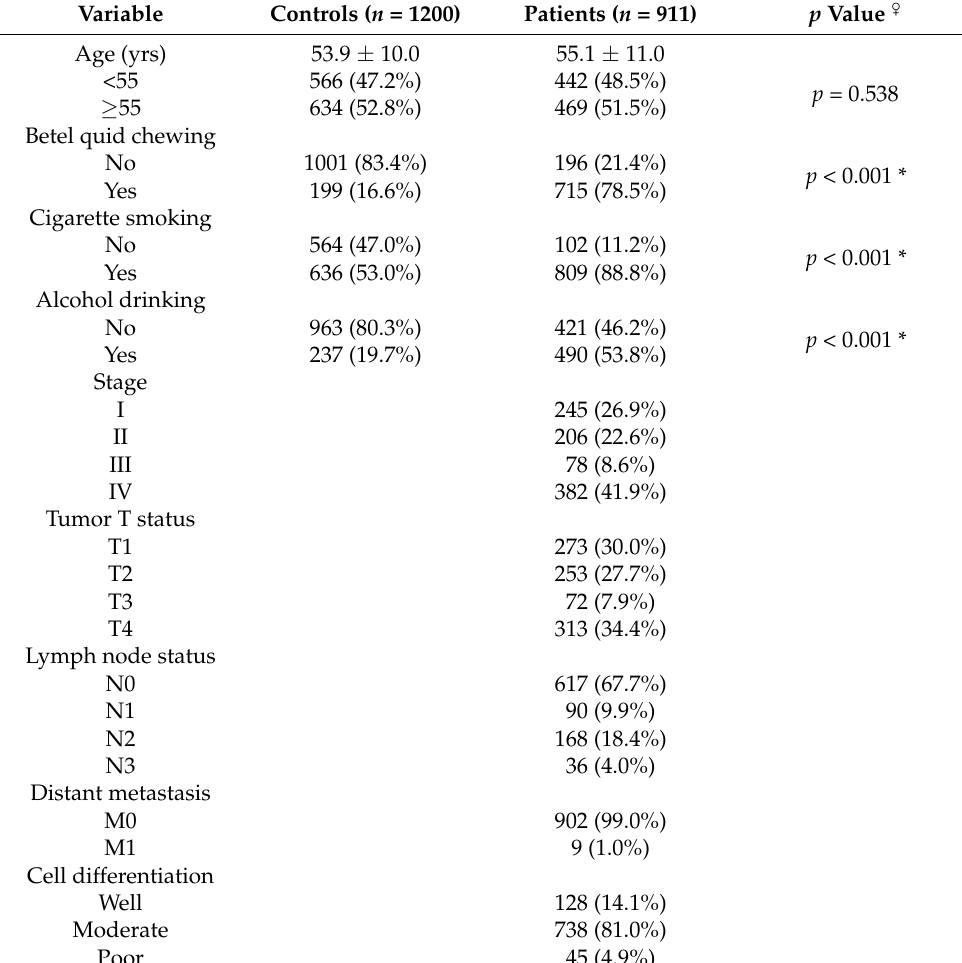
Table 1. The distributions of demographical characteristics and clinical parameters in 1200 controls and 911 patients with